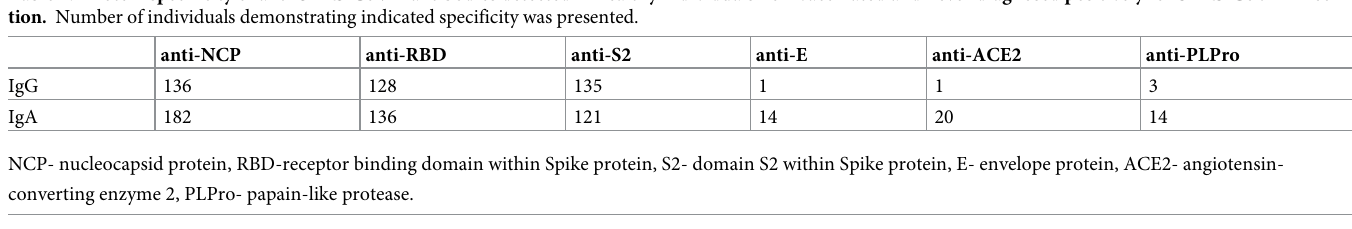
Table 2. Protein specificity of anti-SARS-CoV-2 antibodies detected in healthy individuals non-vaccinated and never diagnosed positively for SARS-CoV-2 infec- tion. Number of individuals demonstrating indicated specificity was presented. anti-NCP